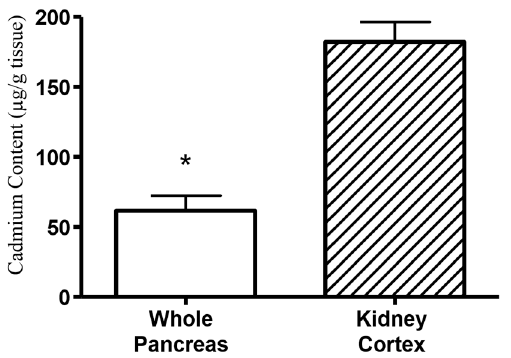
Figure 5. Data represent Cd content of whole pancreas and kidney cortex from 12 week Cd treated (0.6 mg/kg/day) animals. An asterisk (*) denotes significant differences ( t -test, p ≤ 0.05, n = 4 for each data point).